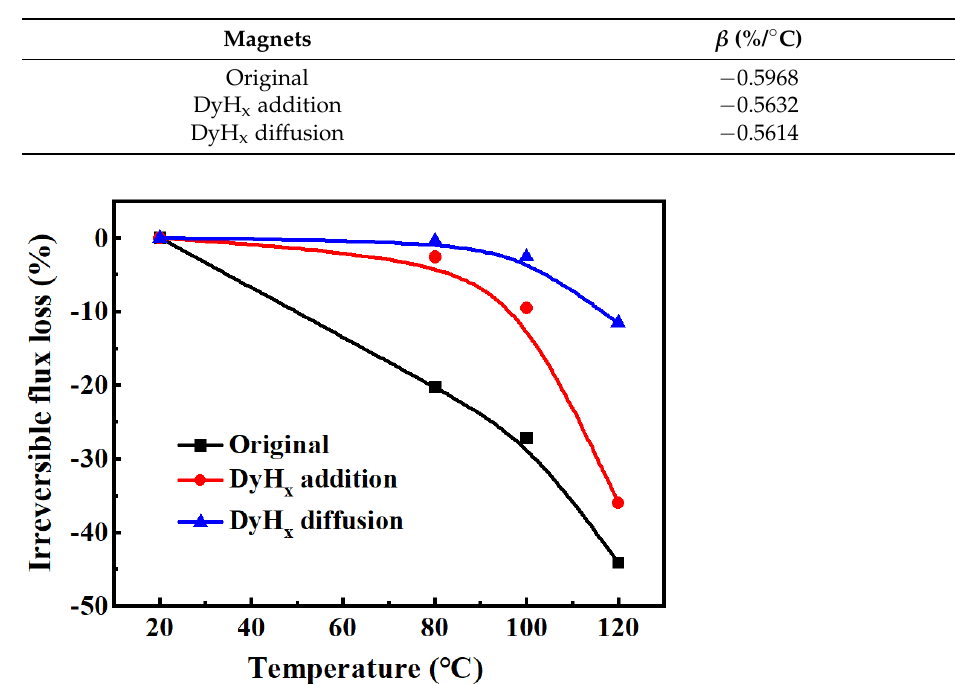
Figure 6. The coercivity versus temperature of the original magnet, the DyH x addition magnet, and the DyH x diffusion magnet. Table 2. The coercivity temperature coefficient β from 20 °C to 120 °C of the magnets.